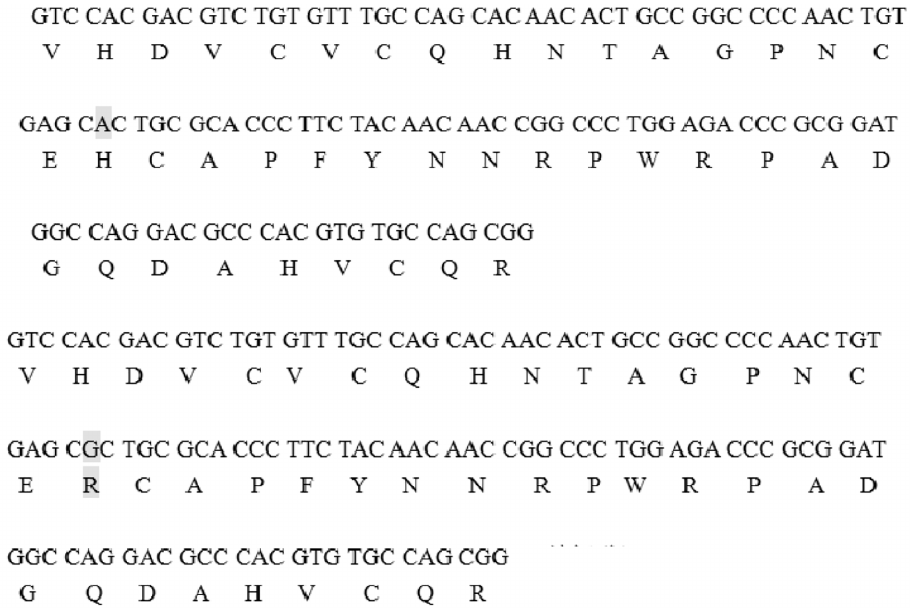
Fig 7. The nucleotide and amino acid sequences of eighth exon of lamb3. The upper one was the amino acid sequence of exon8 in LAMB3 in un-plaice rex rabbit; and the under one was the sequence in plaice rex rabbit.